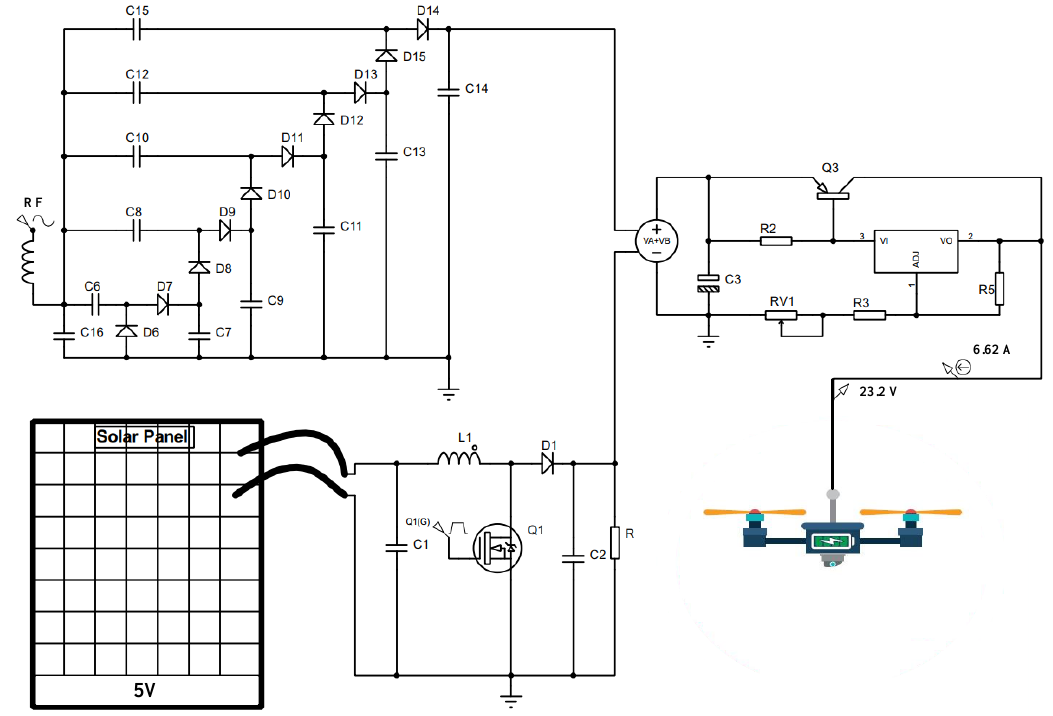
Figure 9. The proposed hybrid solar-RF harvesting energy